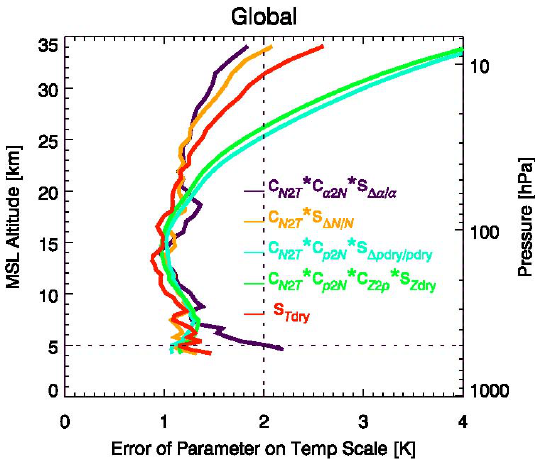
Fig. 4. GRACE-A minus ECMWF standard deviation in Jan- uary 2008 shown for different atmospheric parameters, scaled to the same x-axis. The scaling factors, which are derived empirically, are given in the